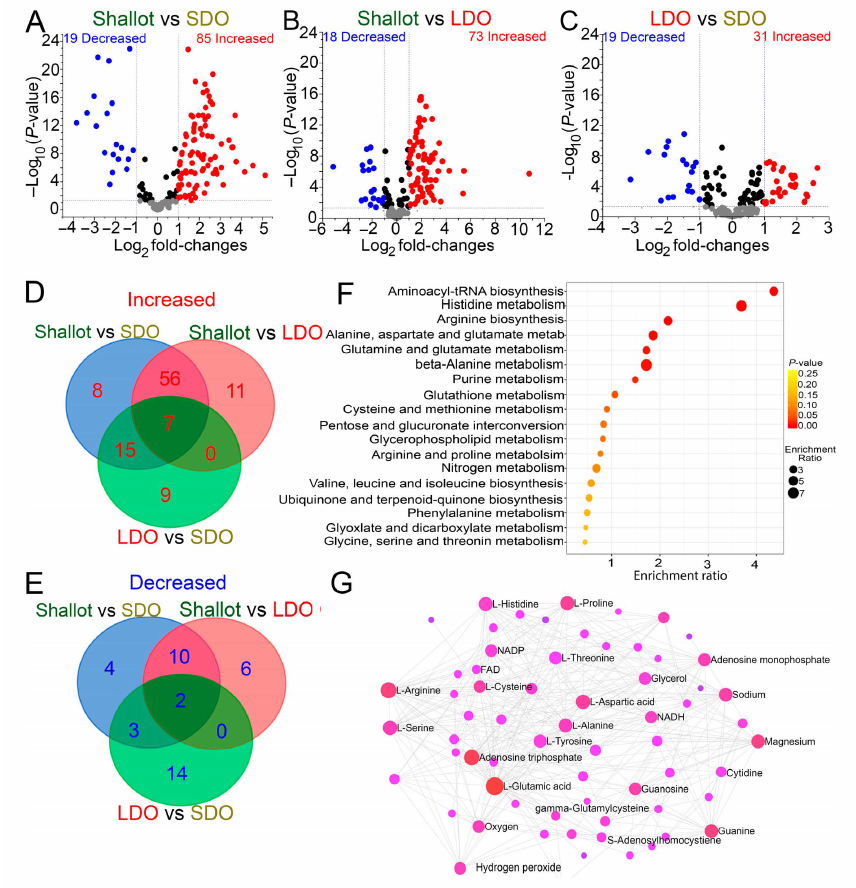
Figure 4. Volcano plots, Venn diagrams, pathway enrichment and metabolite-metabolite interaction networks of differentially produced metabolites (DPMs) in Indonesian shallot landraces and Japanese long-day and short-day onions (LDOs and SDOs, respectively), under normal growth